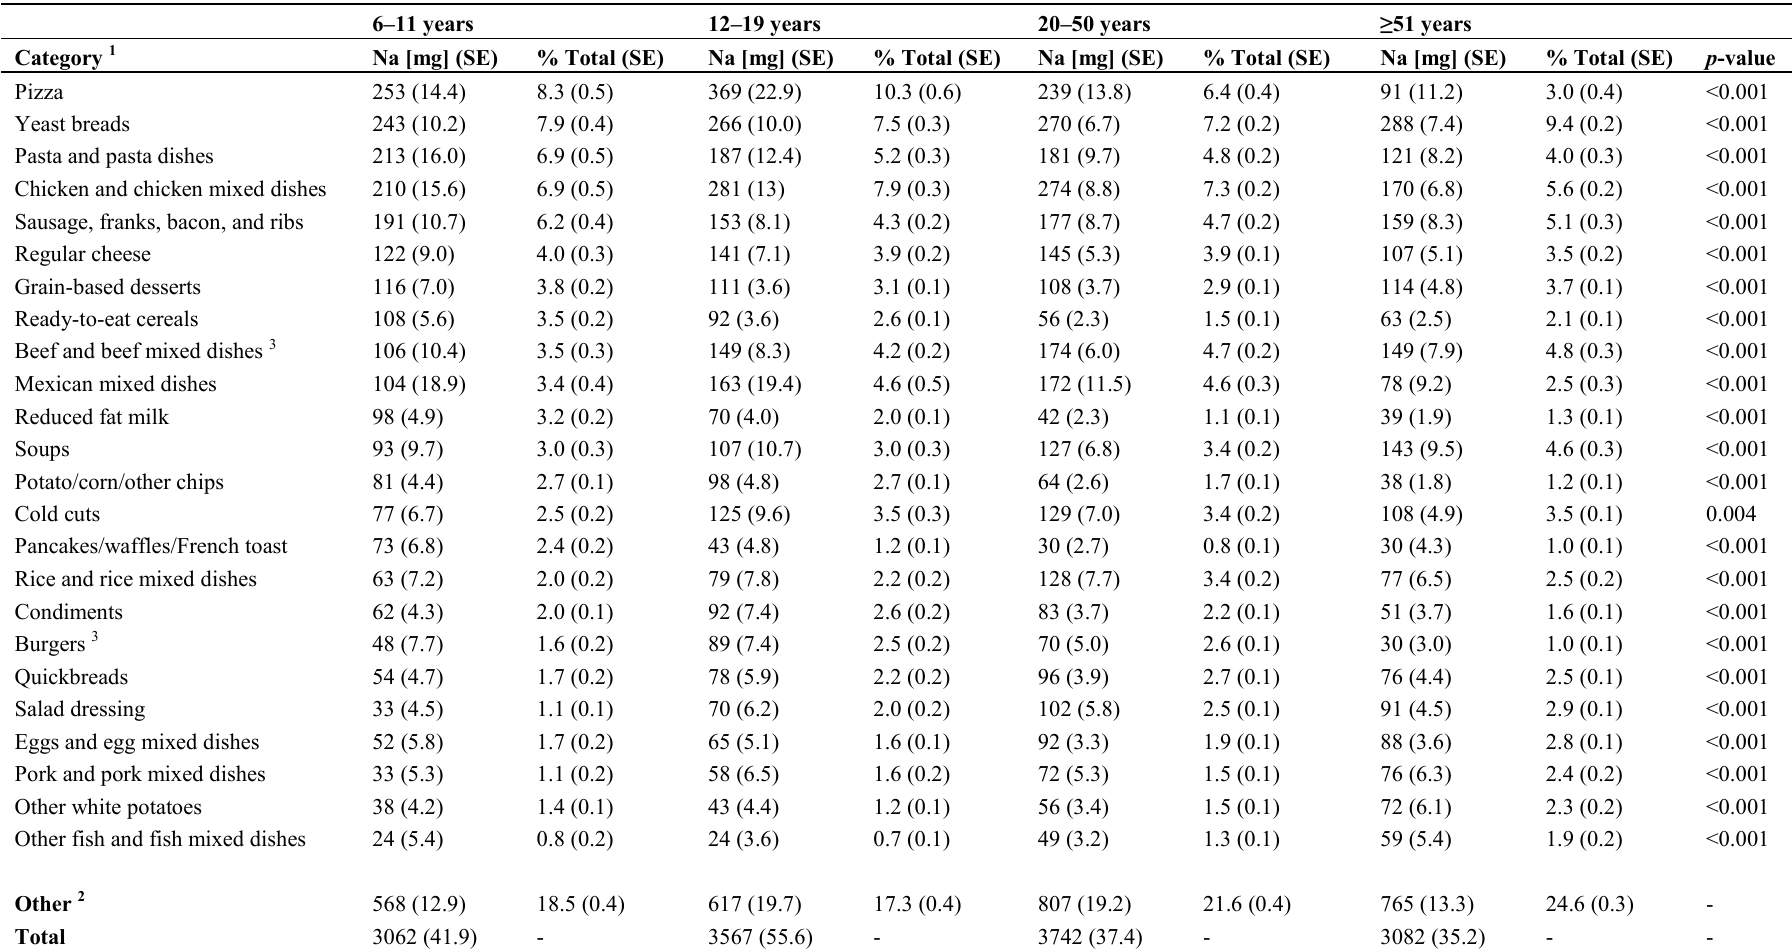
Table 1. Contribution to dietary sodium by specific food sources by age group, NHANES